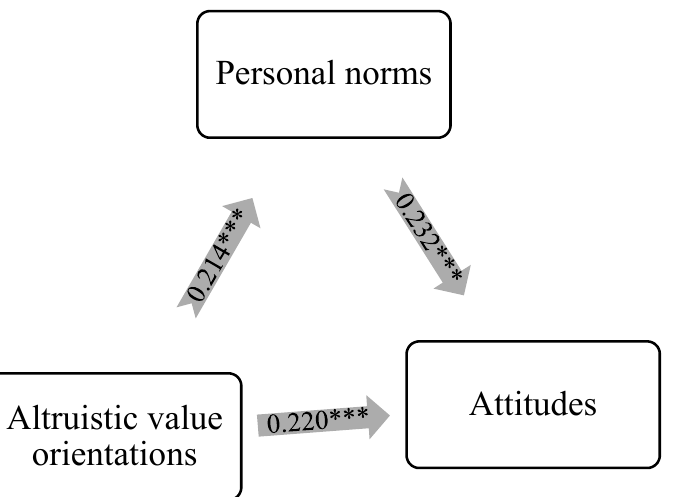
Figure 2. Mediation relationship between altruistic values, personal norms, and attitudes controlling for knowledge. Note: *** p < 0.001.